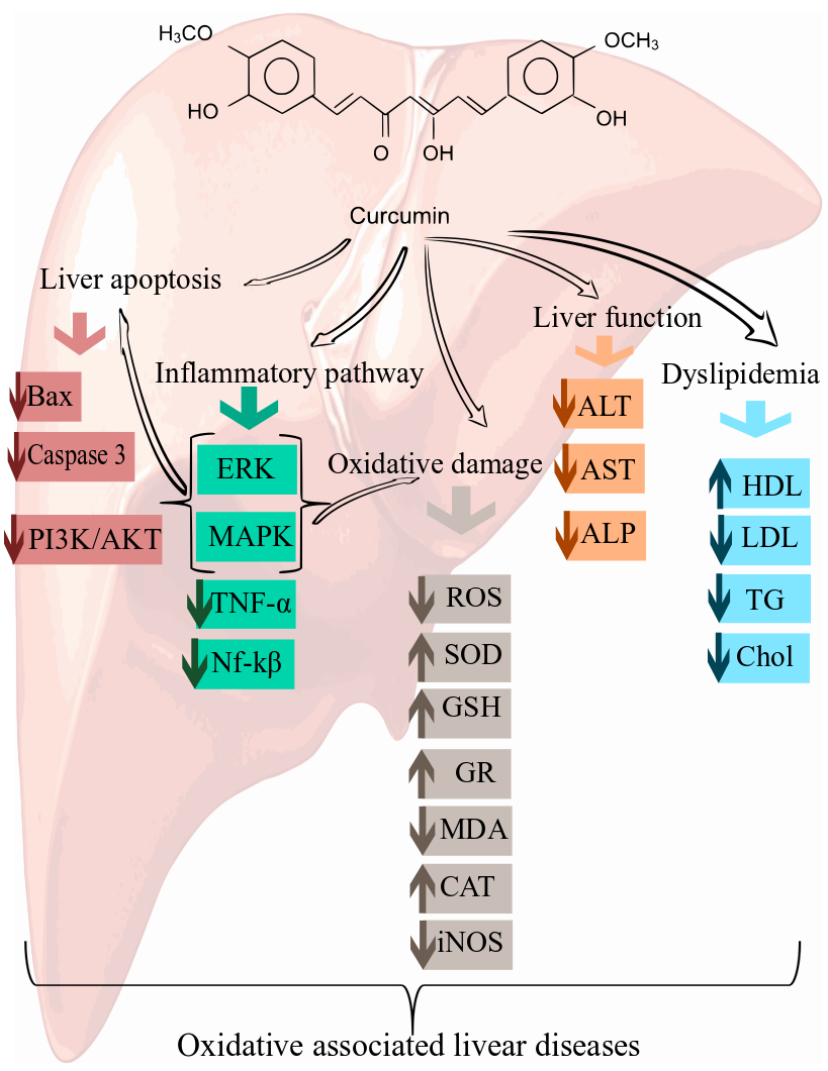
Figure 2. Cellular and molecular mechanisms of curcumin in the prevention of oxidative-associated liver disease. Alanine aminotransferase (ALT), aspartate aminotransferase (AST), alkaline phosphatase (ALP), reactive oxygen species (ROS), sulfasalazine reduces superoxide dismutase (SOD), glutathione (GSH), glutathione reductase (GR), malondialdehyde (MDA), catalase (CAT), inducible nitric oxide (iNOS), high-density lipoprotein (HDL), low-density lipoprotein (LDL), triglyceride (TG), extracellular signal-regulated kinases (ERK), mitogen-activated protein kinase (MAPK).